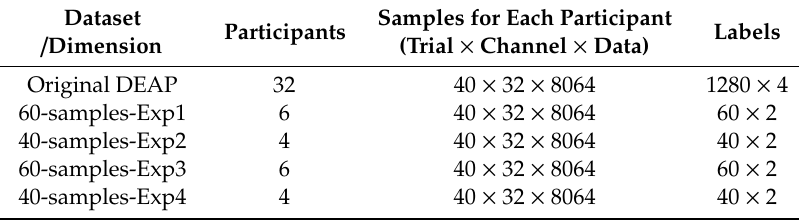
Table 2. Description of the DEAP dataset and our smaller versions of